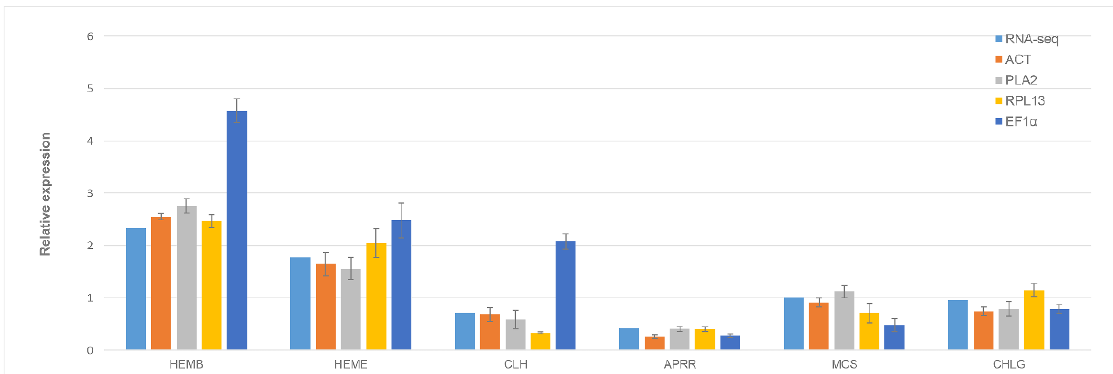
Figure 3. Relative quantification of six genes’ expression between wild type and mutant in K. paniculata , as determined by RNA-seq and RT-qPCR with 4 HKGs. Error bars represent standard error of the mean; data shown are means ± SE.